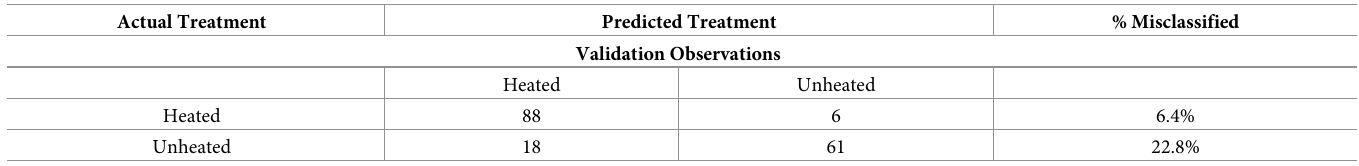
Table 8. Nominal logistic regression model observation-level prediction